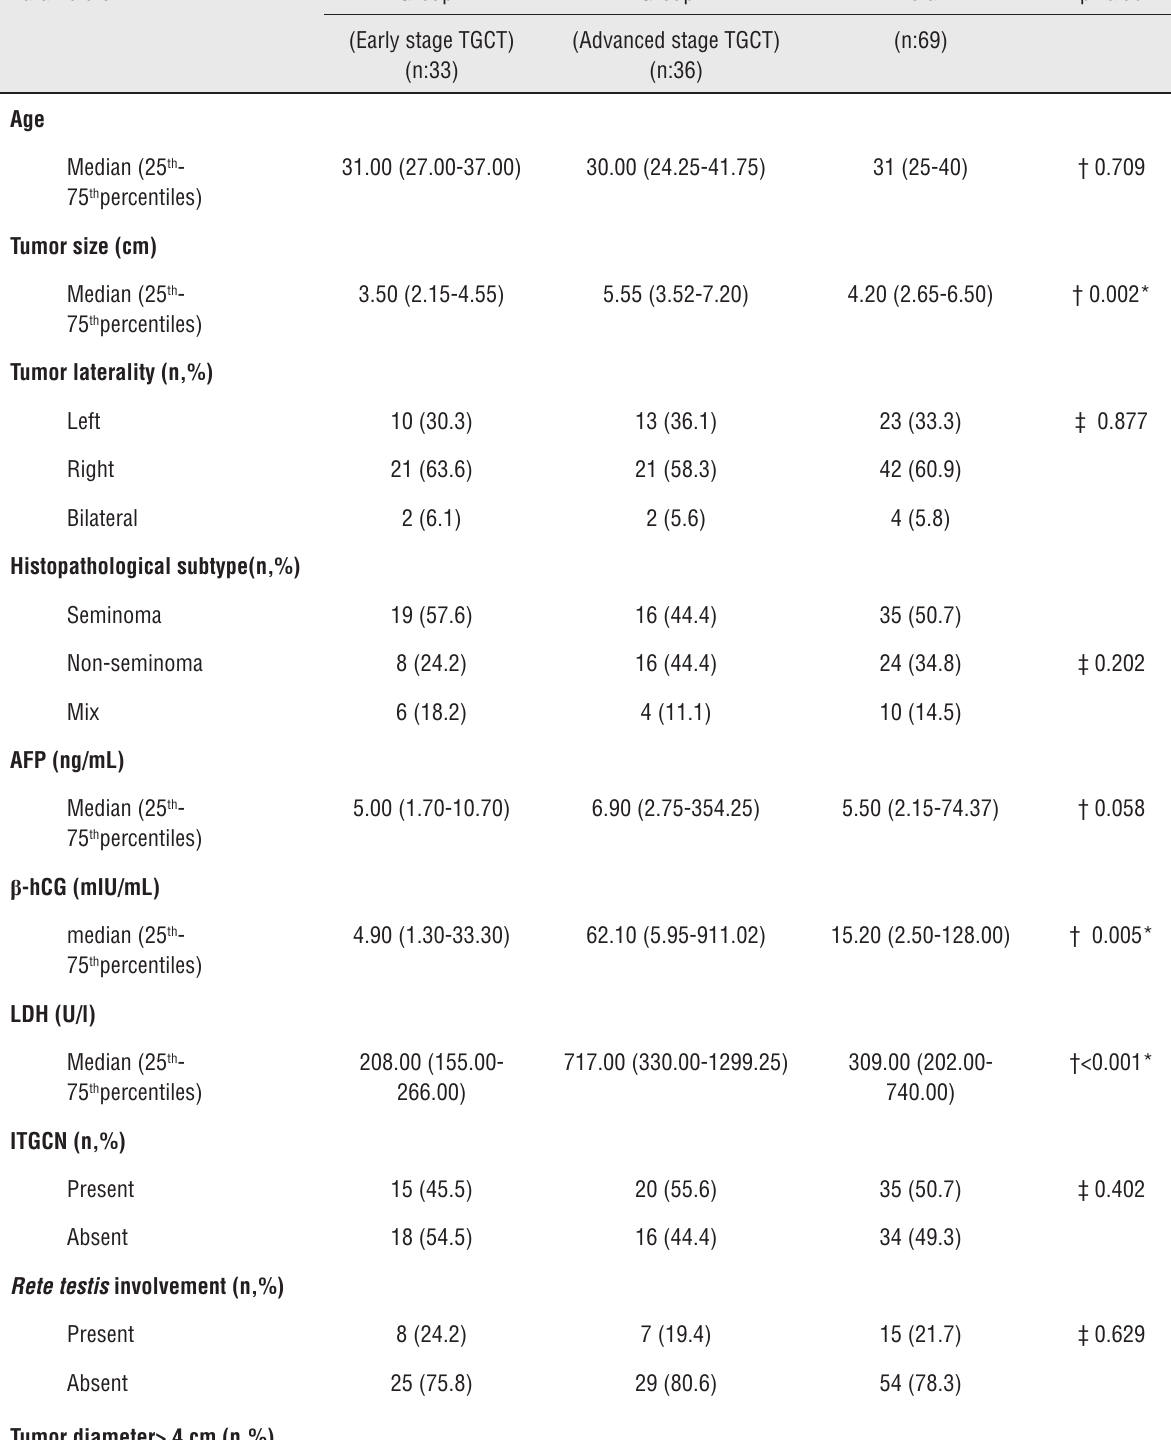
Table 2 - Demographic, pathological, clinical data and oncologic outcomes of the patients.